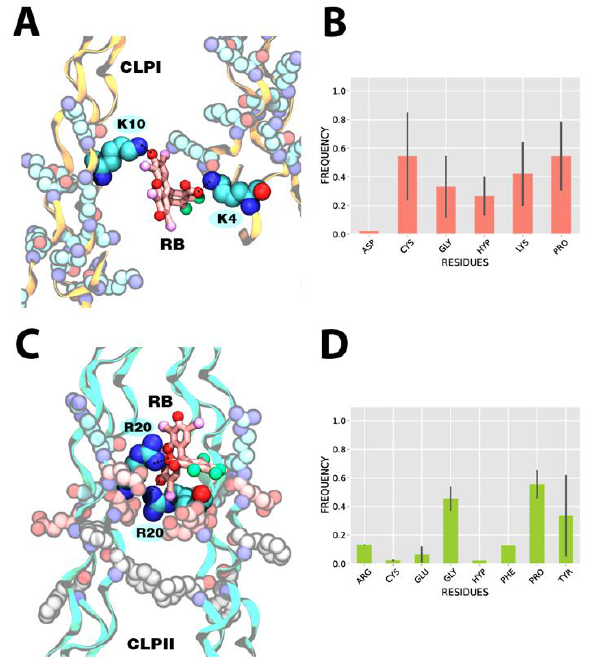
Figure 3. Structural bridge generated by RB with CLPI and CLPII fibers. ( A ) Representative snapshot of a bridge generated by RB between two fibers of CLPI. ( B ) Average contact frequency and standard deviation of residues that allow stabilization of RB-CLPI complex, once a reference interaction with Lys residues has been established. ( C ) Representative snapshot of a bridge generated by RB between two fibers of CLPII. ( D ) Average contact frequency and standard deviation of residues that allow stabilization of RB-CLPII complex once a reference interaction with Arg residues has been established.